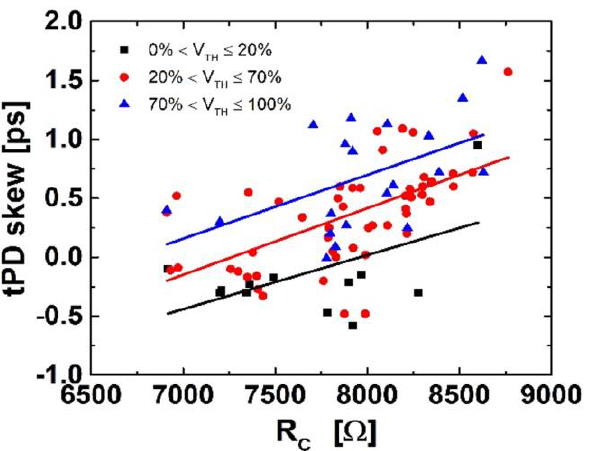
Figure 7. t PD median skew between hot (85 °C) and cold ( − 25 °C) temperatures as a function of threshold voltages and contact resistances.